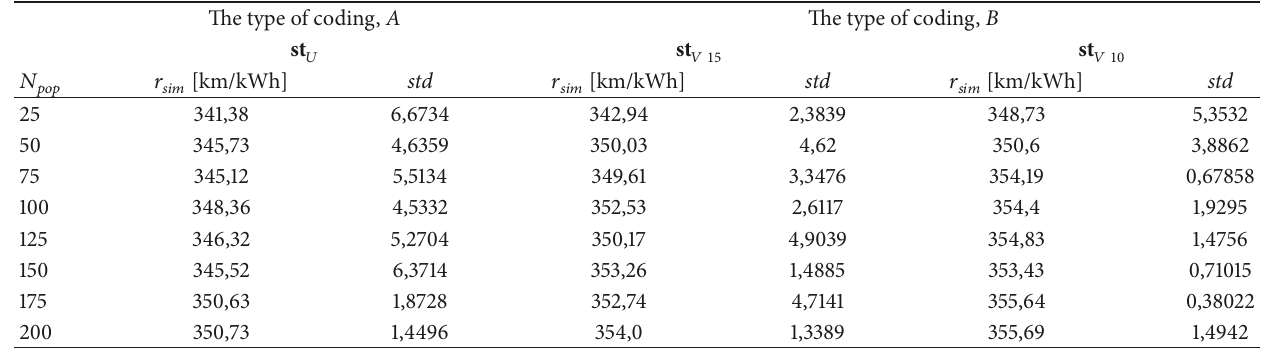
Table 7: The results for route 2.